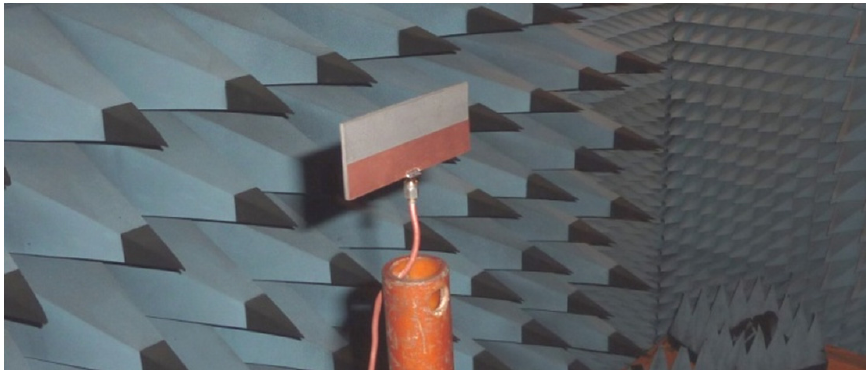
Figure 5. Longer variant of four-element antenna array in anechoic chamber during measurements.